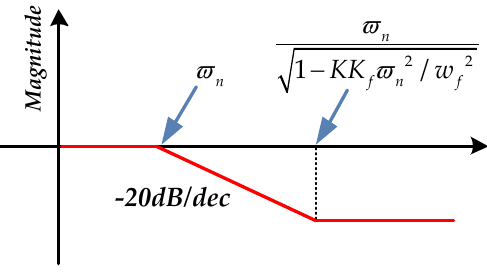
Figure 5. The diagrammatic sketch of the lead-lag corrector.